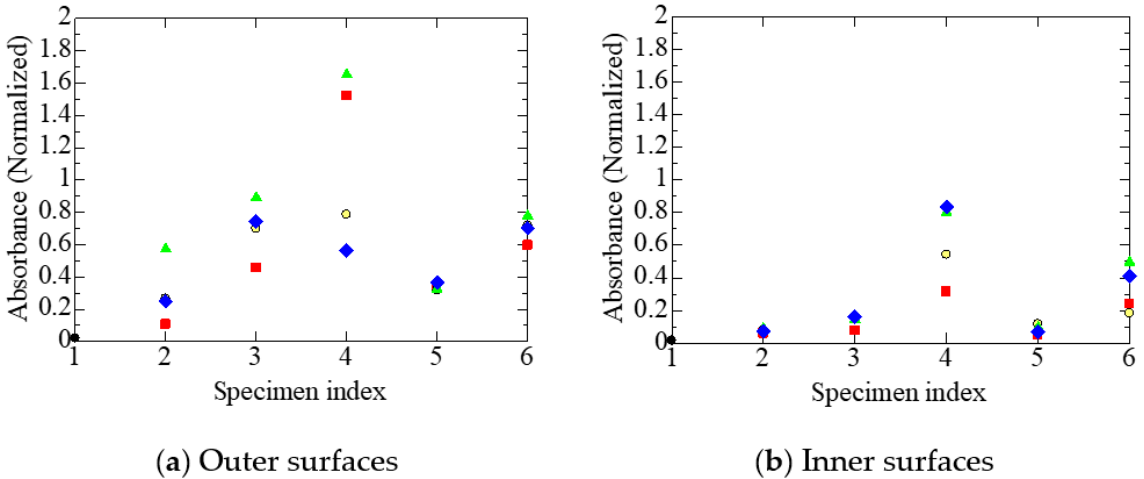
Figure 6. Normalized absorbance due to OH groups measured at each stage on various tubular specimens. Refer to Tables 1 and 2 and Figure 4 for the meanings of the numerals on the abscissa and sample symbols.